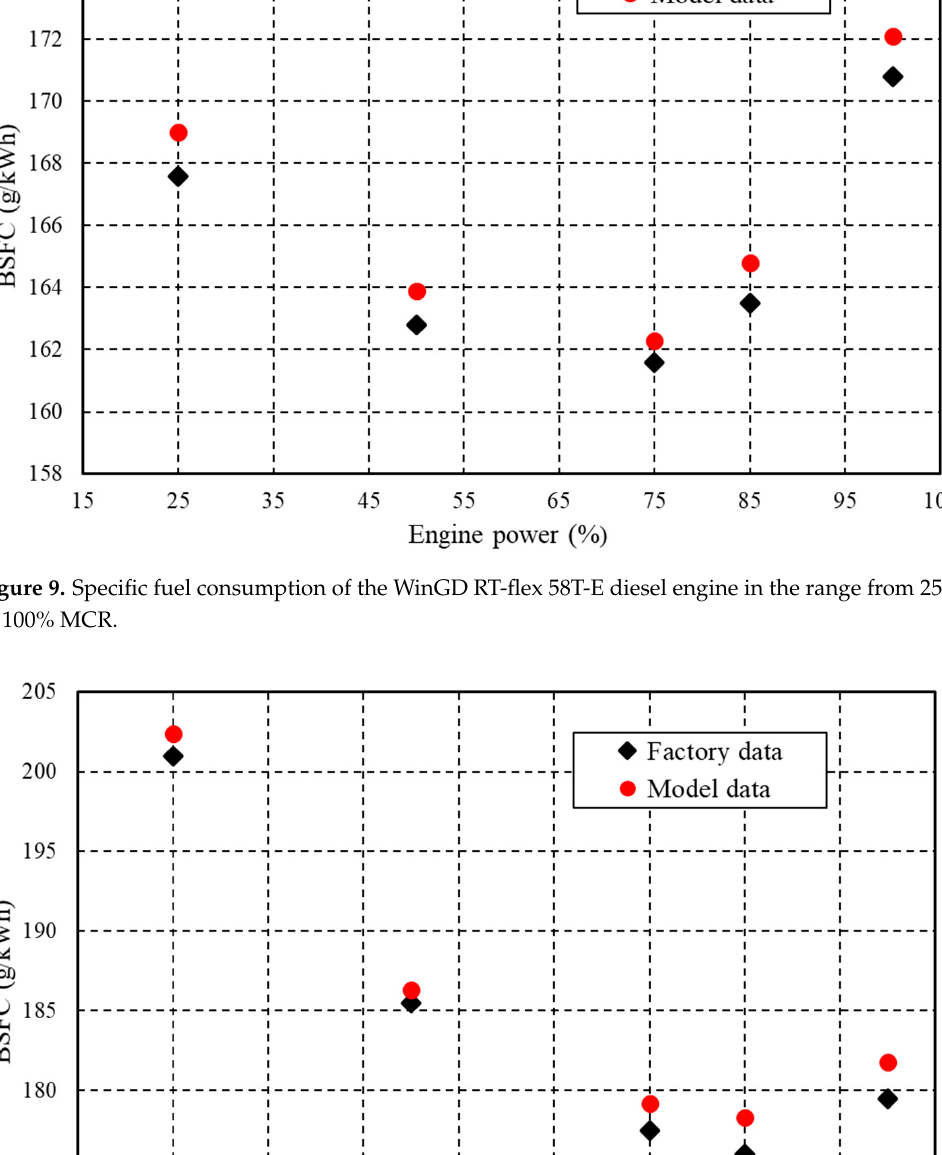
Figure 8. Speci fi c fuel consumption of the WinGD X62-B diesel engine in the range from 25% to 100% MCR.